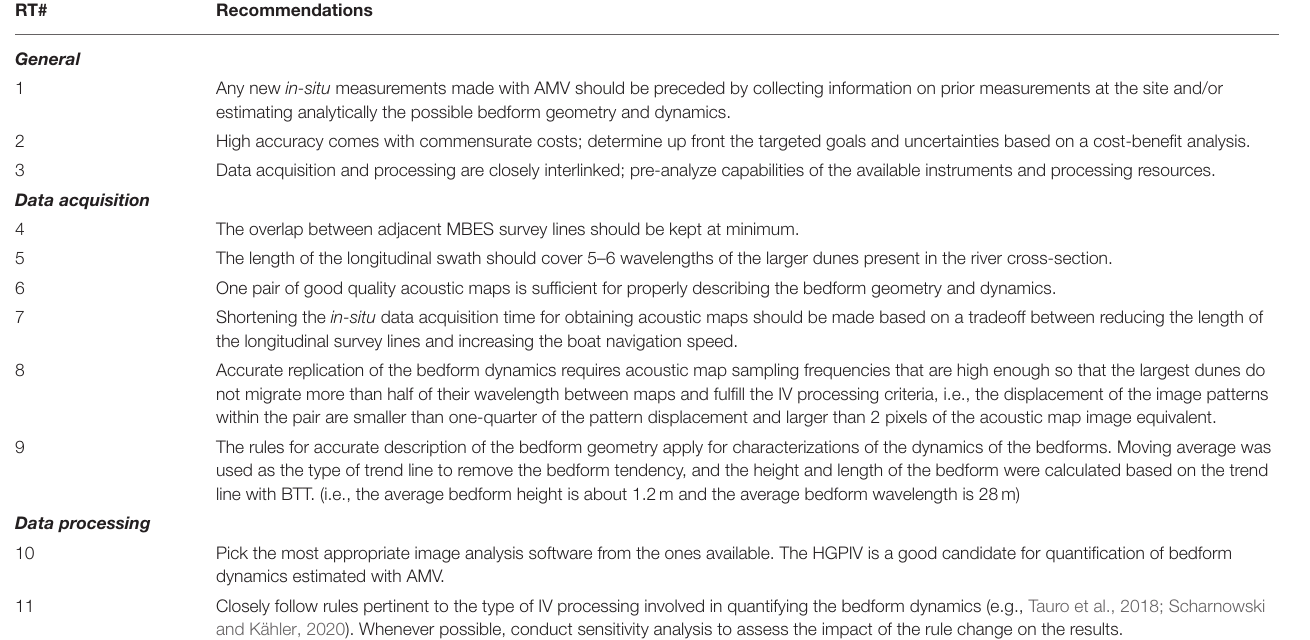
TABLE 4 | Rules of thumb for in-situ implementation of IV component of